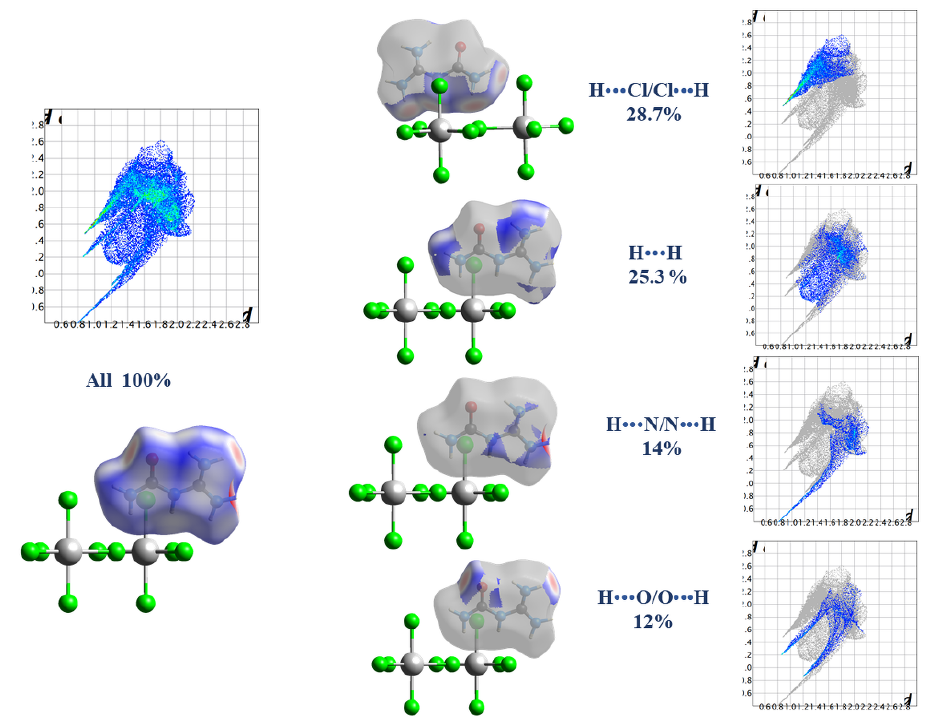
Figure 4. The full 2D fingerprint plot for (C 2 H 7 N 4 O) 2 BiCl 5 and fingerprint plots delineated into